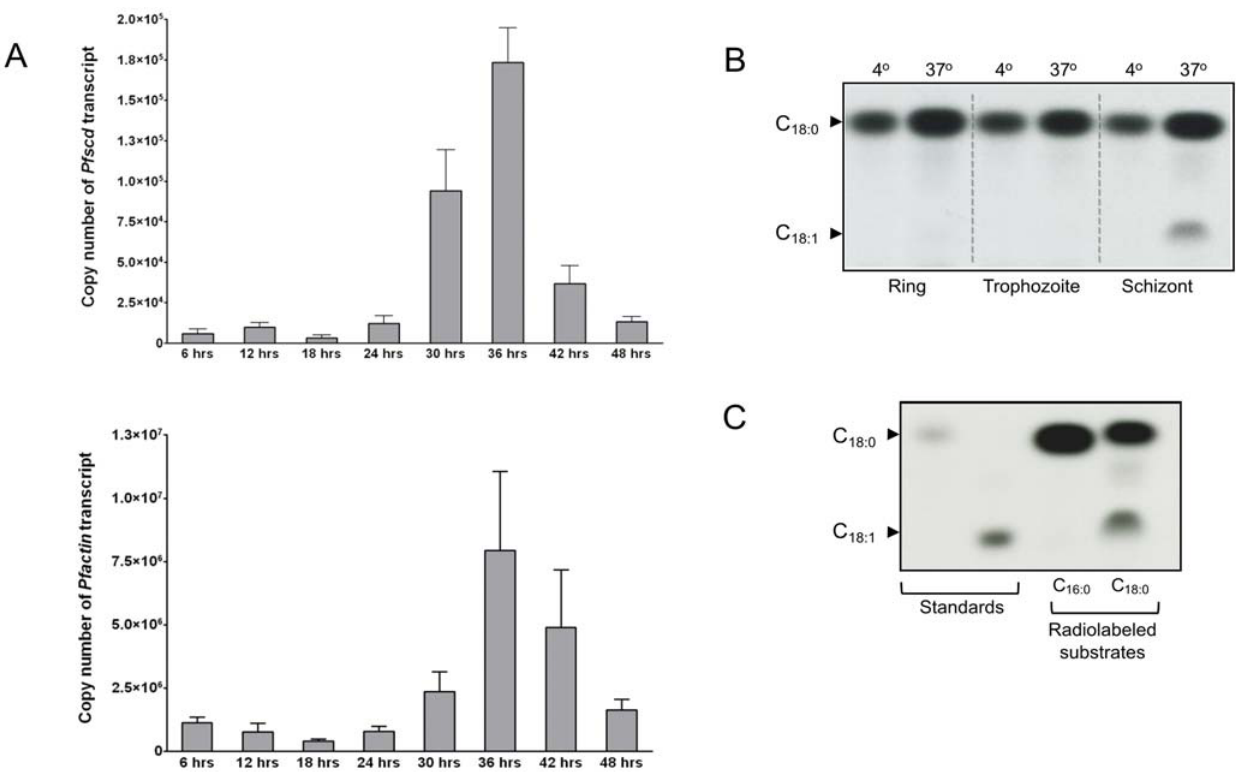
Figure 2. Stage-specific expression of Pfscd and stearoyl-CoA desaturase activity in P.falciparum . (A) Transcriptional profile of Pfscd ( PFE0555w ) as determined using quantitative RT-PCR. Total mRNA from synchronized P. falciparum was extracted every 6 hrs for one complete cycle (48 hrs). The mRNA was reverse-transcribed and the cDNA subjected to quantitative PCR using Pfactin as a reference gene. Results are expressed as transcript copy numbers, presented as the mean 6 SEM of 2 independent experiments performed in triplicate. (B) In vivo stearoyl-CoA desaturase activity. Various parasite stages were labeled with [ 14 C]-stearic acid for 4 hrs either at 4 u C or 37 u C prior to extraction of the fatty acid methyl esters (FAMEs). Equal volumes of each sample (30%) were loaded on the TLC plate and resolved using petroleum ether/diethyl ether (17/3, v/v). C 18:0 and C 18:1 methyl esters were used as standards (indicated by arrowheads). Autoradiograms were exposed overnight to a Kodak Biomax MR film to reveal [ 14 C]-labeled FAMEs. This autoradiogram is representative of results obtained in two independent experiments. (C) Substrate specificity of PfSCD. Schizonts were labeled with either radiolabeled palmitic acid (C 16:0 ) or stearic acid (C 18:0 ) for 4 hrs at 37 u C. Following extraction, equal volumes were loaded on a TLC plate and FAMEs were resolved along with C 18:0 and C 18:1 methyl esters as standards using petroleum ether/diethyl ether (17/3, v/v). These were revealed after overnight exposure to a Kodak Biomax MR film.